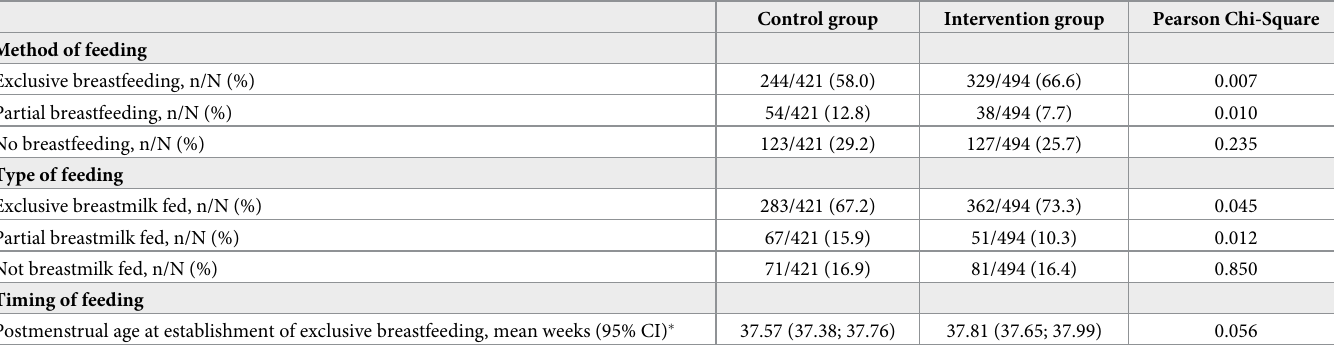
Table 2. Method and type of infant feeding at discharge.